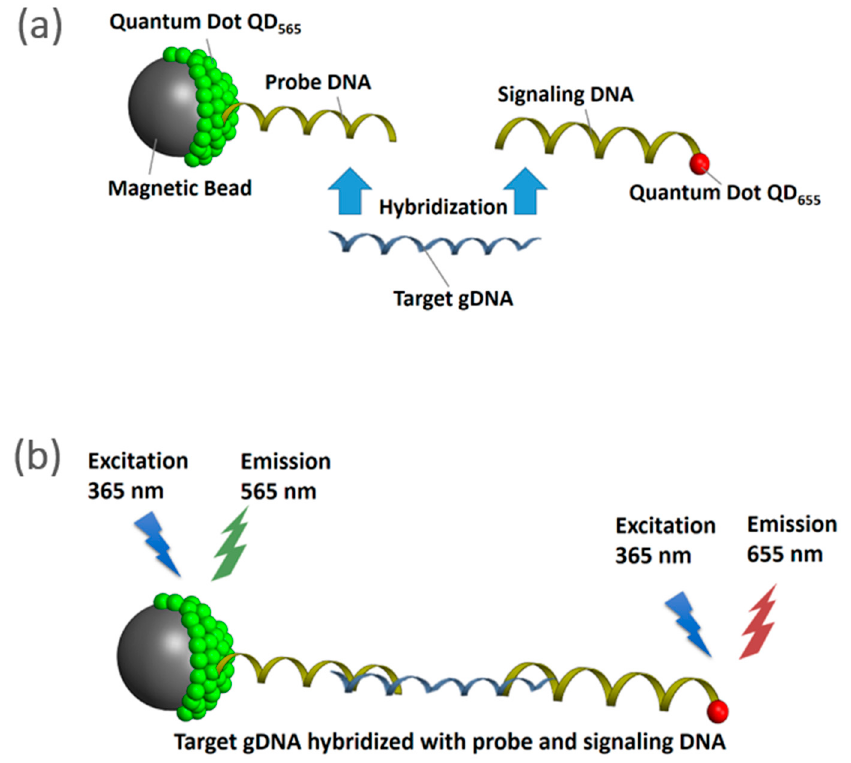
Figure 1. Schematics of the NanoGene assay ( a ) comprised of magnetic beads, quantum dots, and DNA hybridization ( b ) fluorescence measurement.